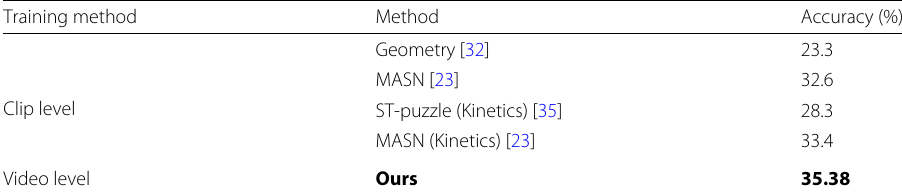
Table 4 Comparison results of the proposed with other state-of-art action recognition methods on